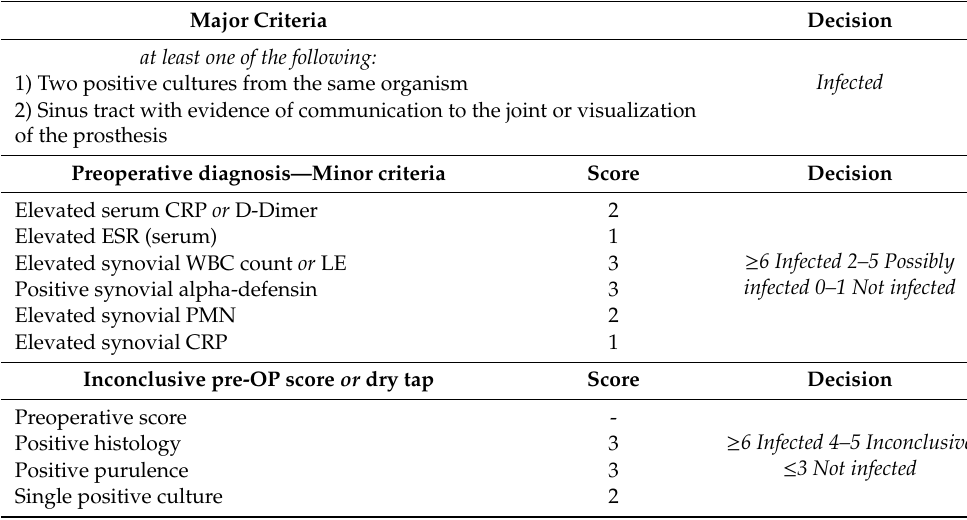
Table 1. 2018 MSIS Criteria for the diagnosis of periprosthetic joint infection (PJI) of the knee or hip by Parvizi et al.